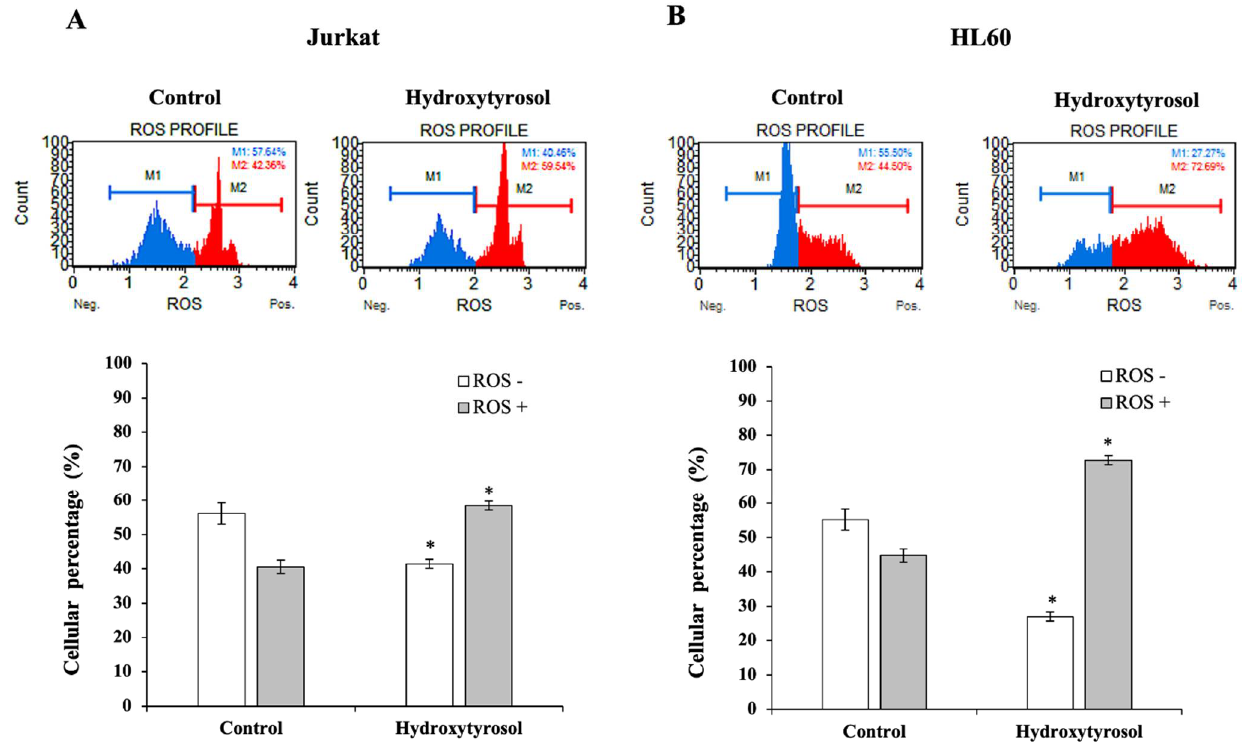
Figure 5. Effect of hydroxytyrosol on the levels of Reactive Oxygen Species (ROS) production in Jurkat (panel A ) and HL60 (panel B ) cell lines. The percentage of negative ROS, ROS ( − ), and positive ROS, ROS (+), values observed for each treatment are represented. Panel A corresponds to Jurkat cells and Panel B to HL60 cells. Cells were treated with hydroxytyrosol IC 50 for 24 h for Jurkat (A) and 72 h for HL60 (B) cells. Histograms from a representative experiment showing the effects of hydroxytyrosol on ROS production are plotted at the top. The lower part represents the percentages of ROS (+) and ROS (−) in the control and treated cultures. Values are expressed as mean ±SEM ( n = 12). The presence of an asterisk indicates significant differences ( p < 0.001) between the levels of ROS (+) and ROS (−) versus control and treatment.